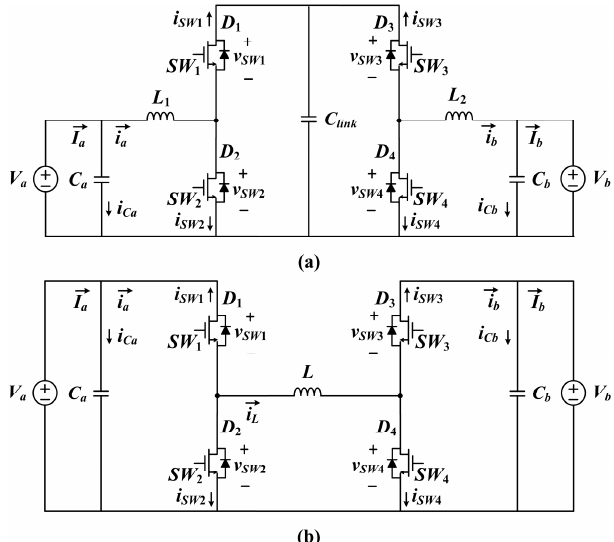
Figure 2. Circuit structures of ( a ) combined half-bridge (CHB) and ( b ) cascade buck–boost (CBB) bidirectional converters (BDCs). Figure 2a is reproduced with permission from Khan, M. A [8]; Figure 2b is reproduced with permission from Waffler, S [11].